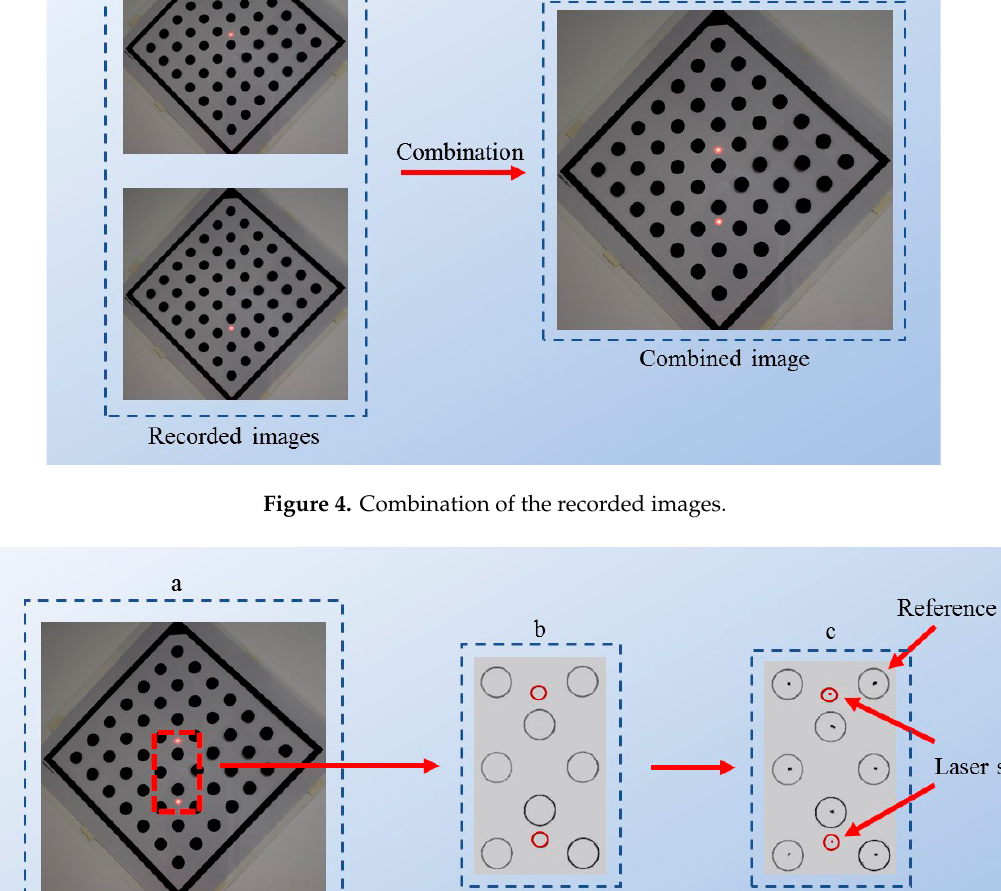
Figure 4. Combination of the recorded images.